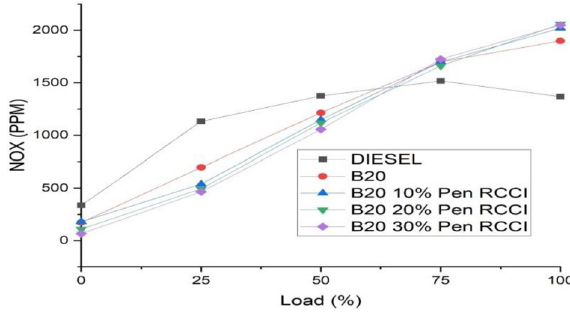
Figure 10. Nitrogen oxide versus load.